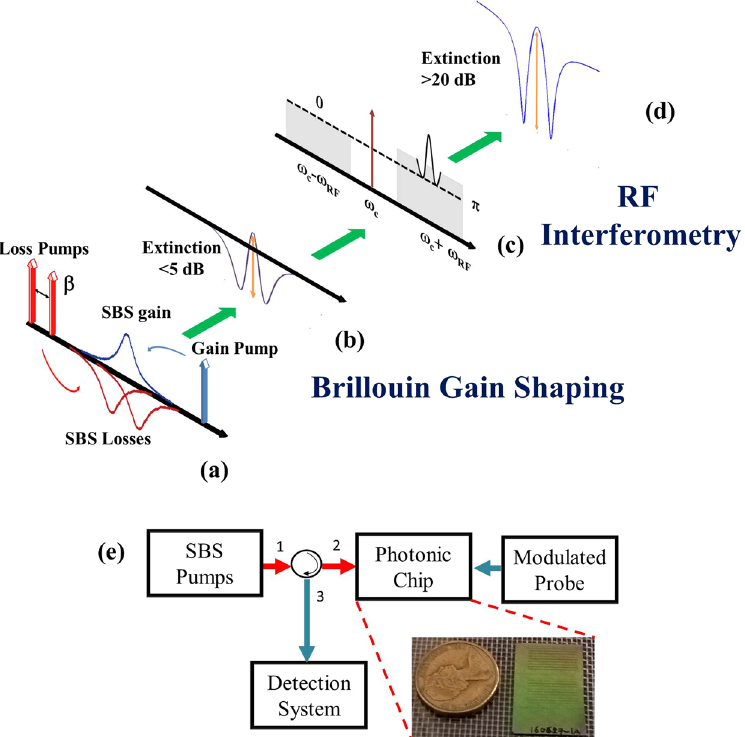
Figure 1. Principle of operation of the RF signal processor in the RF domain. ( a ) One SBS gain pump and two loss pumps were aligned to remove energy from the tail of the Lorentzian profile, ( b ) the optical filter amplitude response, ( c ) the resonance applied to the upper sideband of a phase modulated signal with the lower sideband attenuated, and ( d ) the high suppression filter formed due to RF interference. ( e ) A schematic representation of the experimental setup for realizing an on-chip SBS-based RF signal processor, with a photograph of the photonic chip next to an Australian Dollar